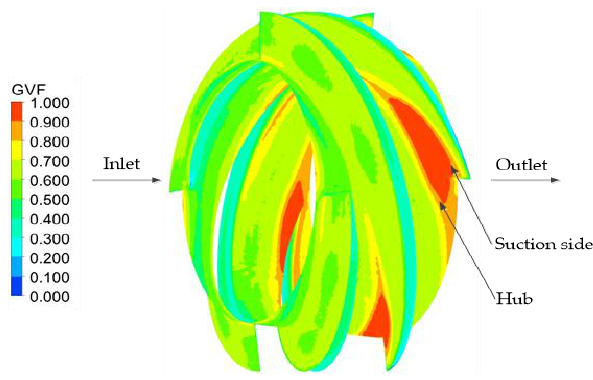
Figure 12. The accumulation of gas in the flow passage.